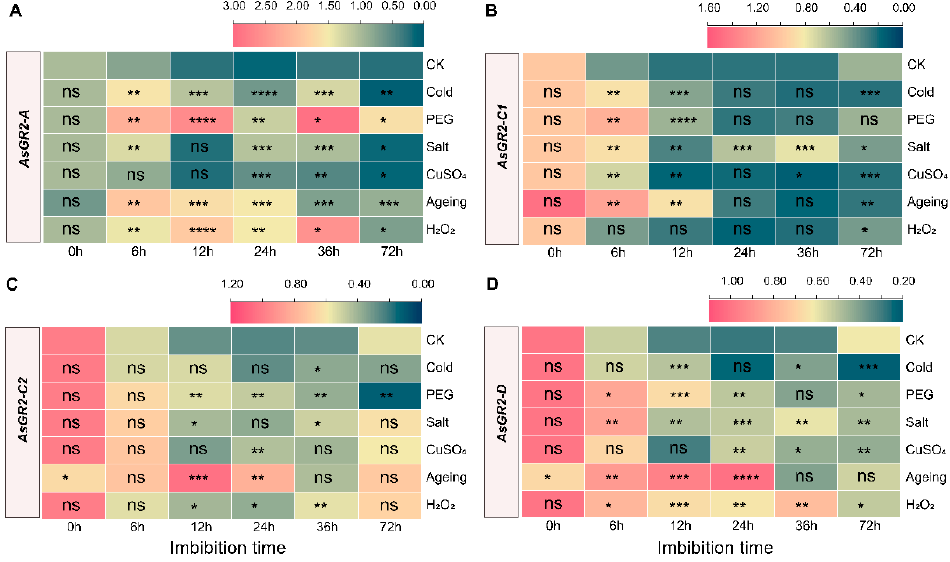
Figure 9. Expression profiling of AsGR2-A ( A ), AsGR2-C1 ( B ), AsGR2-C2 ( C ), and AsGR2D ( D ) during seed imbibition of A. sativa under stress by qPCR. The relative expression was calculated using transcription level of dry seed of CK as reference. The significant expression change in comparison to normal conditions (CK) has been calculated using Student’s t test. * indicates a significant difference at p < 0.05; ** indicates a significant difference at p < 0.01; *** indicates a significant difference at p < 0.001; **** indicates a significant difference at p < 0.0001; ns represents not significant.